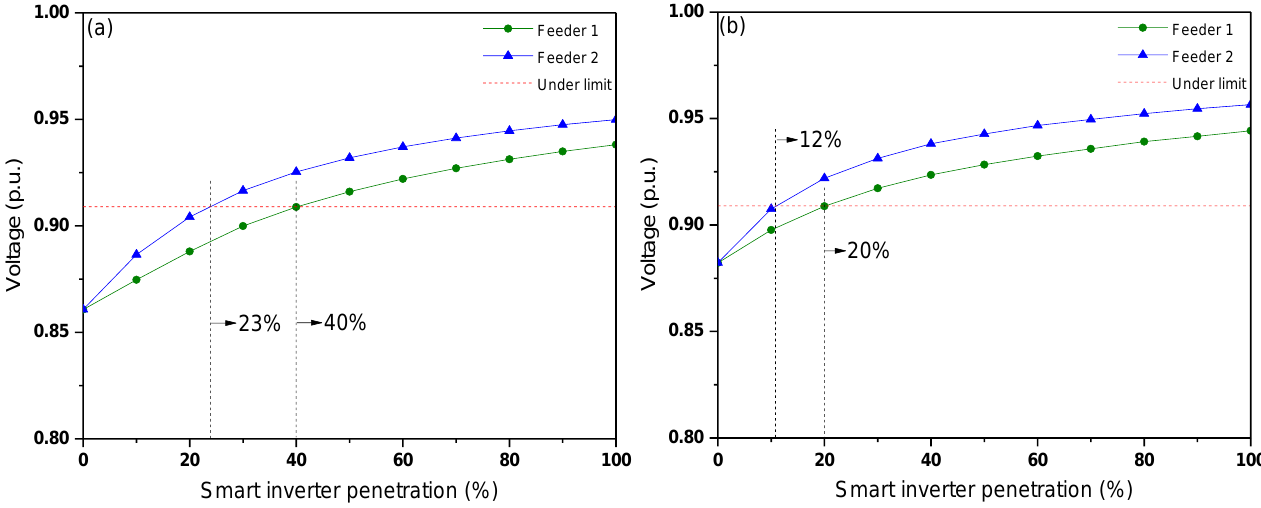
Figure 14. Minimum feeder voltages according to the penetration rate of smart inverters: ( a ) Case 2 and ( b ) Case 5.